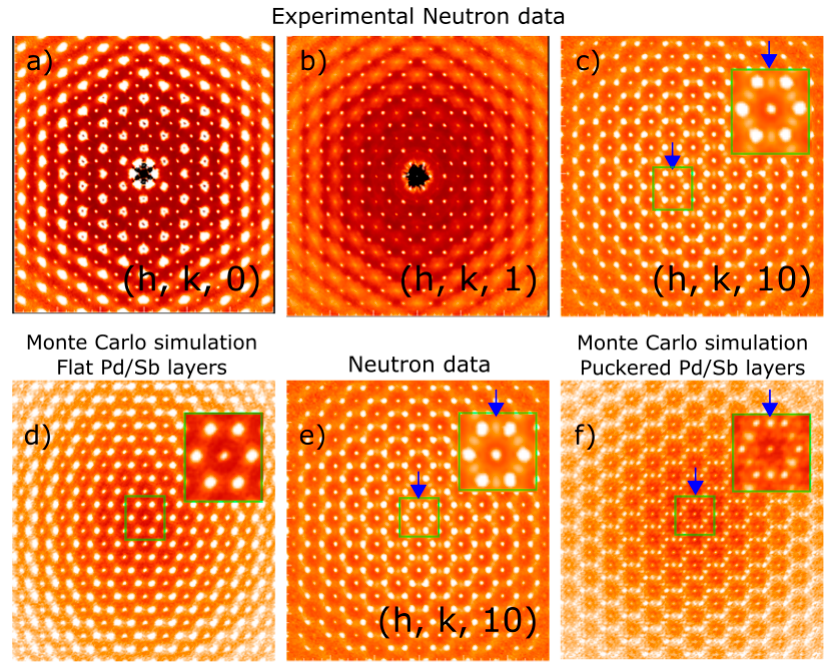
Figure 2. Diffuse scattering for CePdSb: panels ( a – c ) show experimental diffuse scattering for (h, k, 0), (h, k, 1), and (h, k, 10) layers; panels ( d – f ) show the simulated diffuse scattering from the balls-and-springs Monte Carlo simulation corresponding to flat Pd/Sb (model 1) and puckered layers (model 3); blue arrows show the presence of extra features for (h, k, l) layers with large l, panel ( c )-data and highlights the features in the diffuse scattering associated with the presence of puckering, panel ( f )-simulation (Bragg peaks have been subtracted in the MC simulation but not the data); insets show zooms of the region inside the green rectangle.